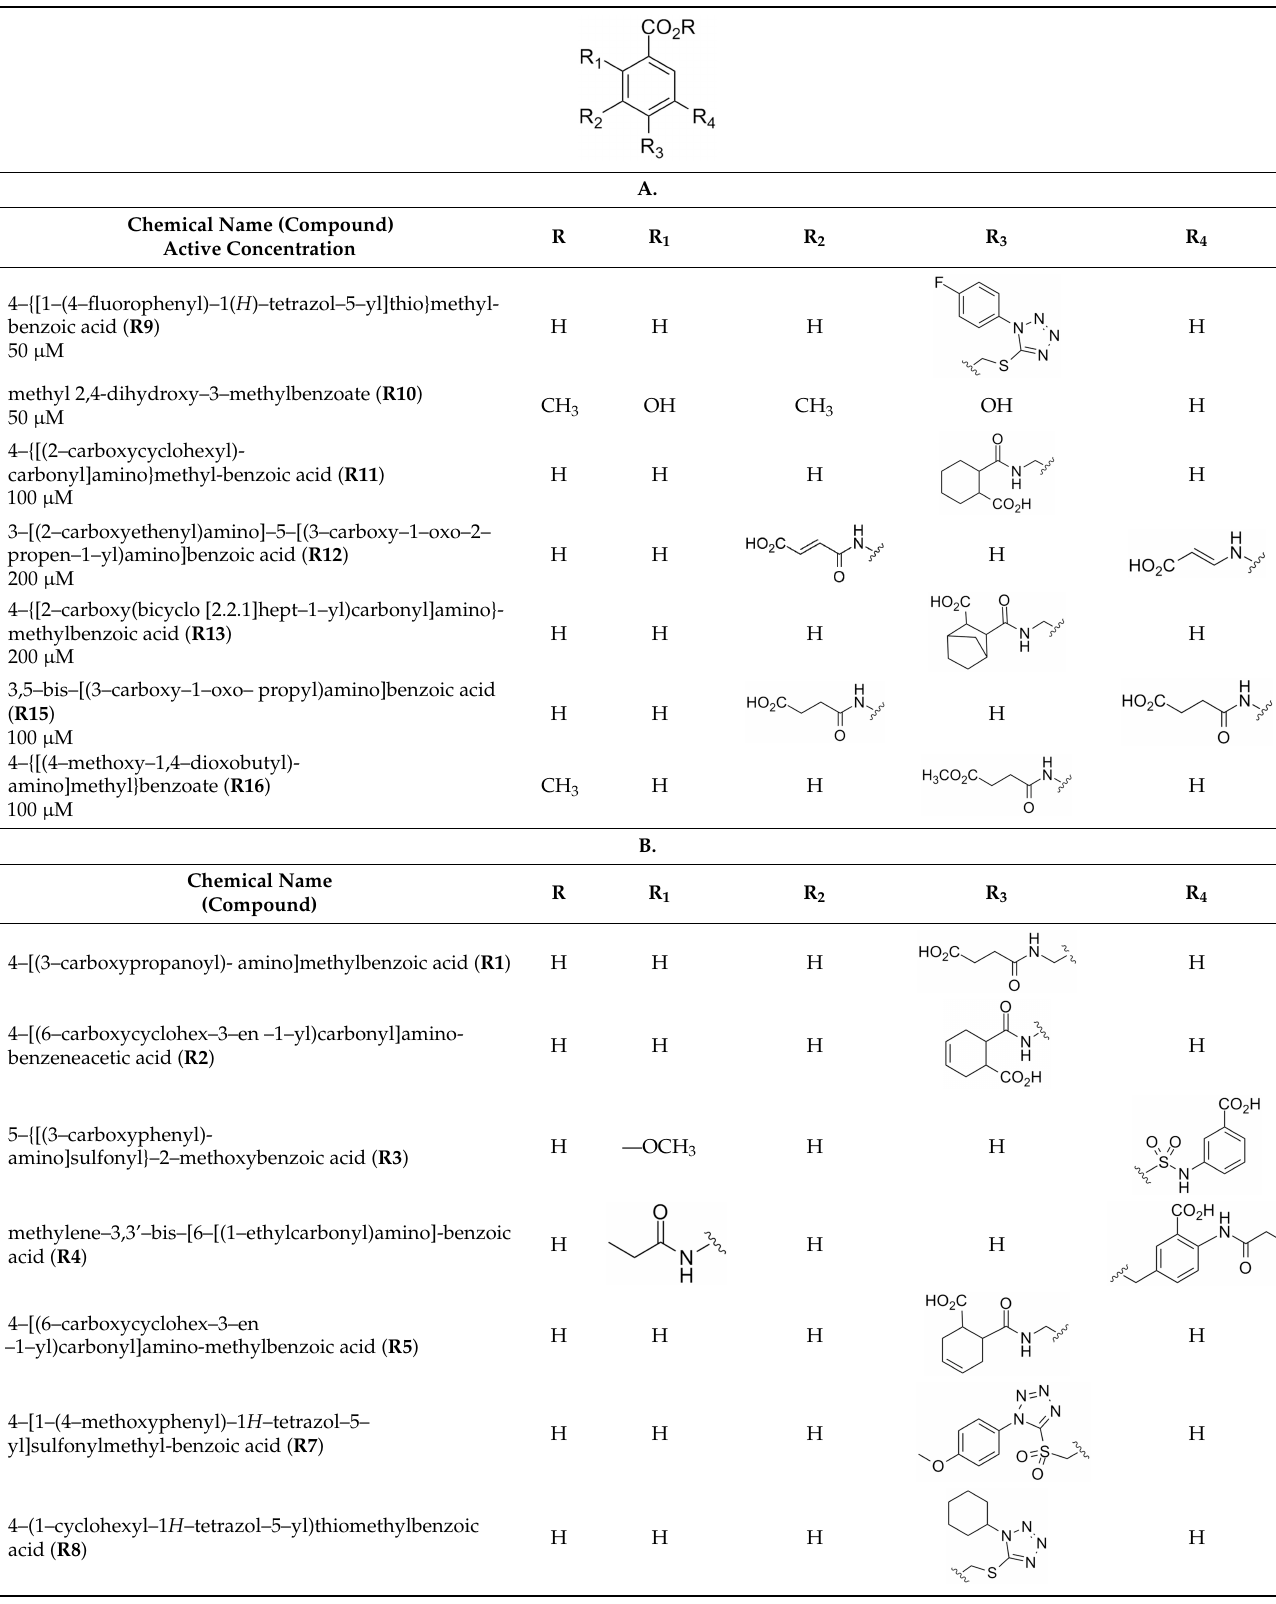
Table 1. Benzoic acid derivatives identified previously through in silico modelling and pharma- cophores screening as putative small molecule IL–15R α inhibitors [11]. A. Molecules with biological activity proven at the indicated concentrations. B. Inactive benzoic acid